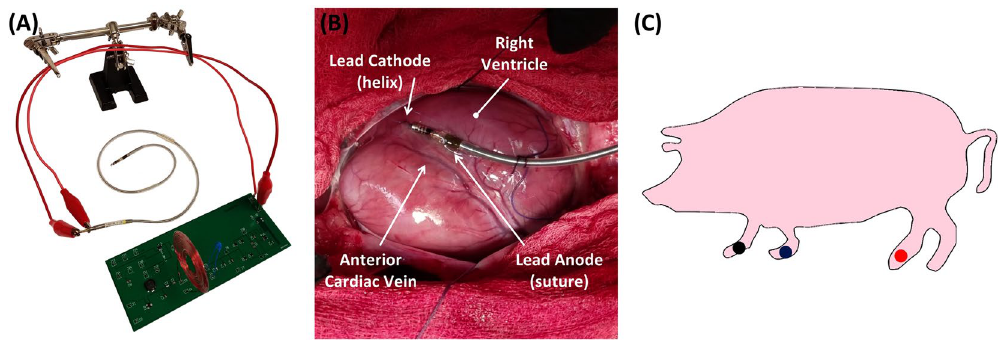
Figure 4. Experimental Setup. ( A ) PCB with transmitter and receiver circuitry and the output of the receiver electrically connected to the anode and cathode of an existing bipolar lead; ( B ) implant location of the bipolar lead on the porcine heart with the cathode at the distal tip fixated via helix into the epicardial wall and the anode proximal to the cathode in the form of a ring fixated via sutures; ( C ) ECG lead placement shown via the blue, red, and black